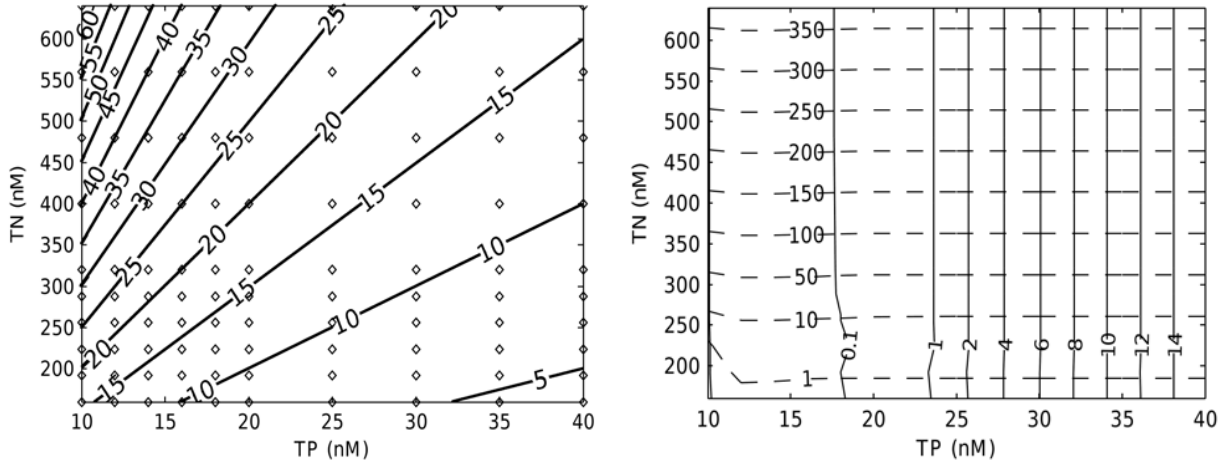
Fig. 3. (a) Range of total nitrogen (TN) and total phosphate (TP) concentrations tested with the model (diamonds markers represent the TN TP values tested in the different simulations and isolines represent the TN to TP ratio). (b) Inorganic nutrient concentrations at steady state in nM as a function of TN and TP (dashed lines represent inorganic nitrogen and solid lines inorganic